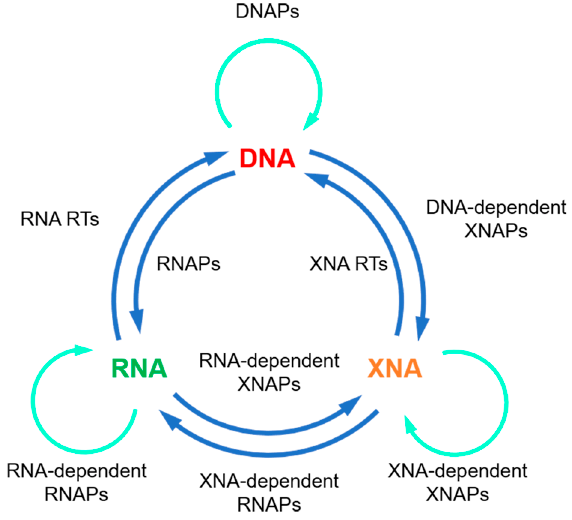
Figure 2. Expansion of the central dogma with XNAs and XNAPs. Green arrows: replication; blue arrows: transcription or reverse transcription.